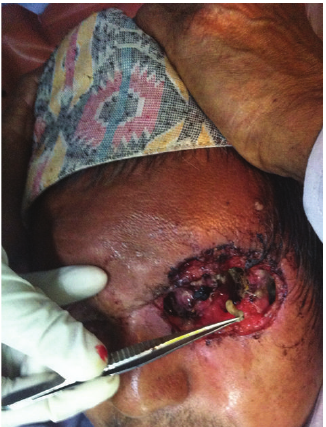
Figure 1: Clinical photograph showing extent of the wound and manual removal of a